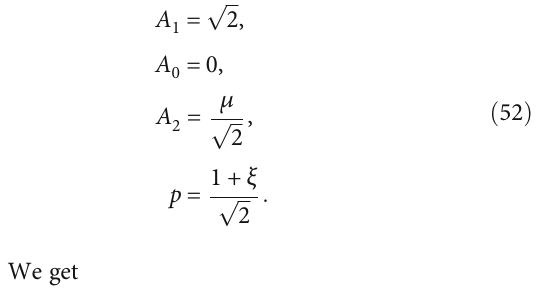
Figure 2: Solutions of conformable fractional KPP equation (Case 1) considering η = 2 : 1 , m = 1 , δ = 1 , μ = 1 , γ = 1 , β = 1 , β = 0 : 8 , β = 0 : 6 , and β = 0 : 4 .